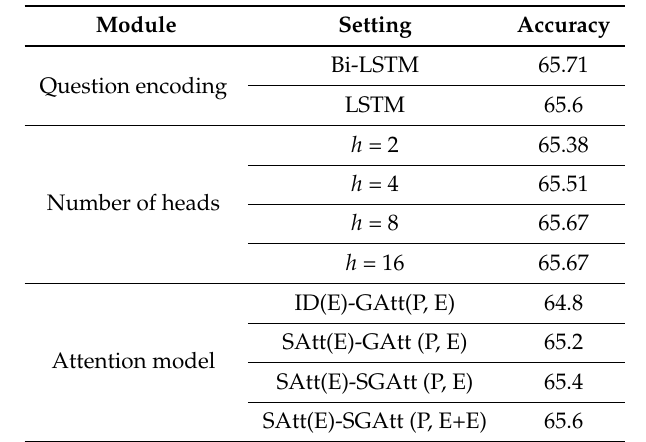
Table 1. Ablation studies of the question encoding, the single-layer attention model, and the number of heads on Visual Question Answering (VQA)-v2 Validation